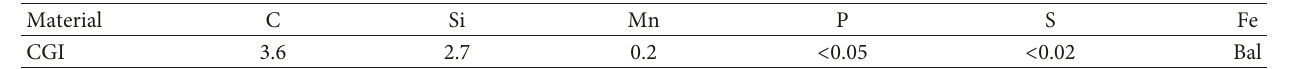
Figure 1: Microstructure of compacted graphite cast iron. Table 1: CGI chemical elemental composition (mass fraction, wt.%).